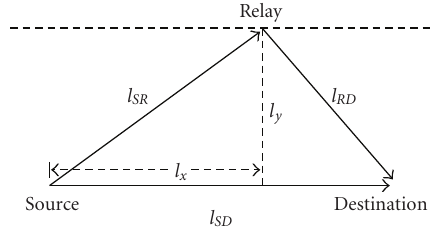
Figure 2: Geometry